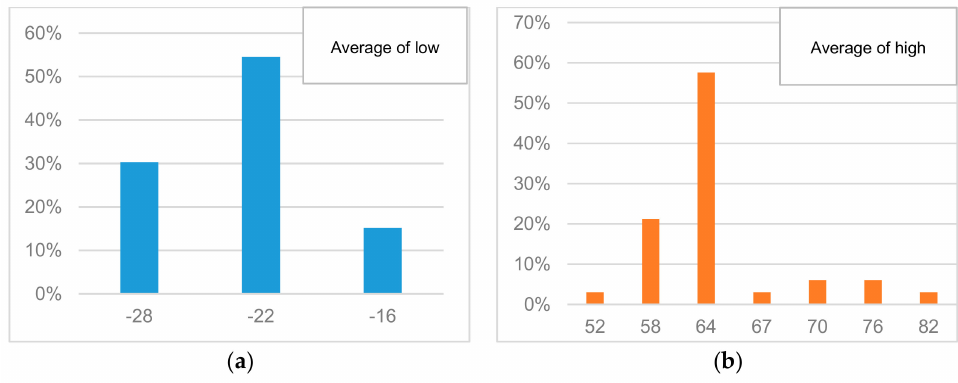
Figure 7. ( a ) Low and ( b ) high temperature PG of the bitumen base used for CR modification.